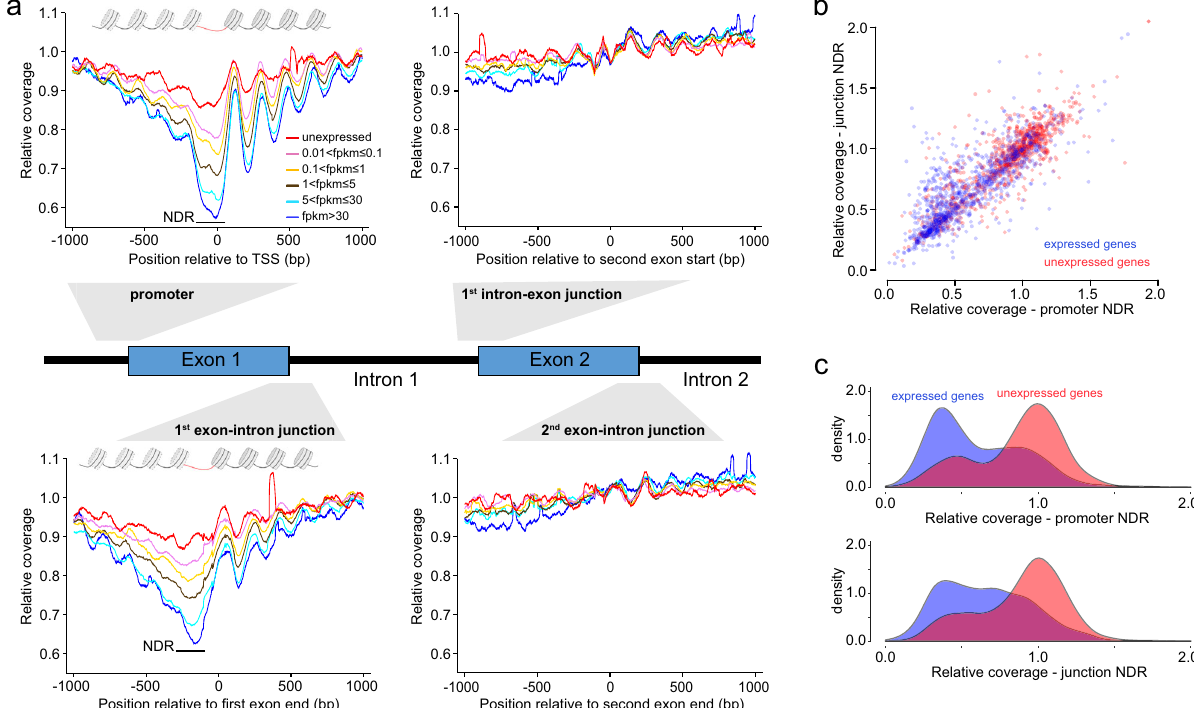
Fig. 2 Characteristics of cfDNA degradation patterns at promoters and exon – intron junctions. a Systematic analysis of gene regulatory regions for association of gene expression and cfDNA relative coverage. Relative coverage refers to cfDNA coverage across the given region when normalized to ±1 kb fl anking regions. The nucleosome-depleted regions of promoter (NDR, − 150 to 50bp relative to TSS) and fi rst exon – intron junction (NDR, − 300 to − 100bp relative to fi rst exon end) are highlighted. b Relative cfDNA coverage of promoter and junction NDRs for expressed (fpkm ≥ 30 in whole blood) and unexpressed genes. c Distribution of promoter and junction NDR relative coverage for expressed and unexpressed